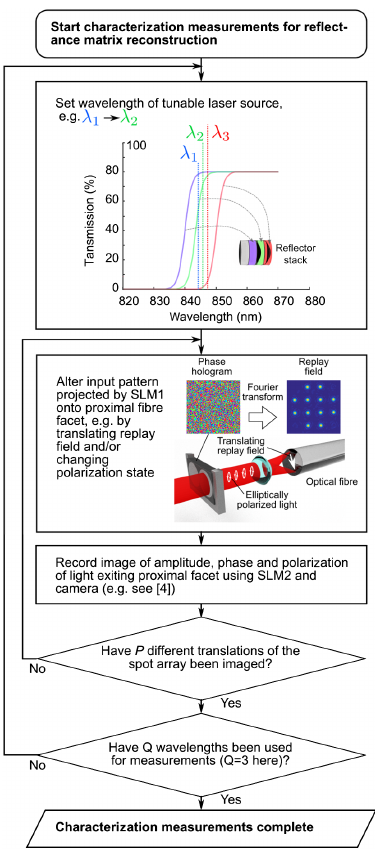
FIG. 12. Flowchart detailing the series of measurements re- quired to recover instantaneous RMs using the setup of Fig.